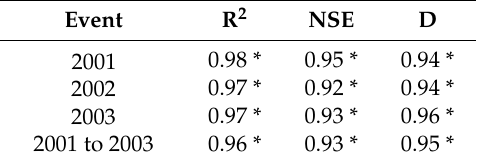
Figure 7. Comparison of simulated and observed discharge at Doiyan (Astore River Basin outlet) along with temperature and precipitation, during the validation period 2001–2003. Table 3. Statistical summary of flow simulation during the validation period